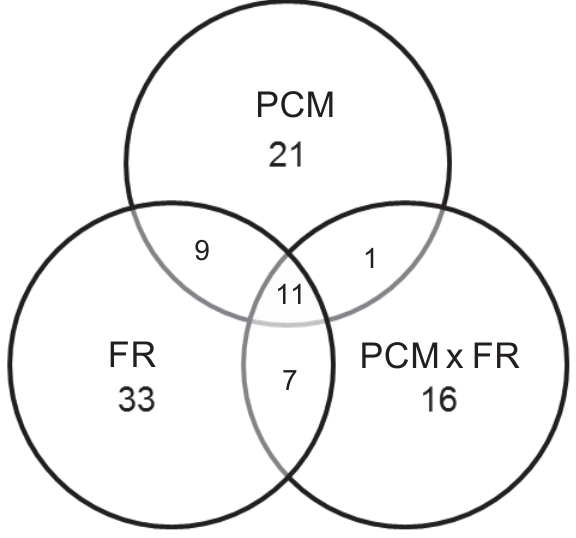
Figure 2. Venn diagram showing the number of protein spots significantly affected by previous crop management (PCM), fertilization regime (FR — composted chicken manure pellets vs. composted cattle manure at 170 kg N ha − 1 ), and the PCM × FR interaction effect ( p <